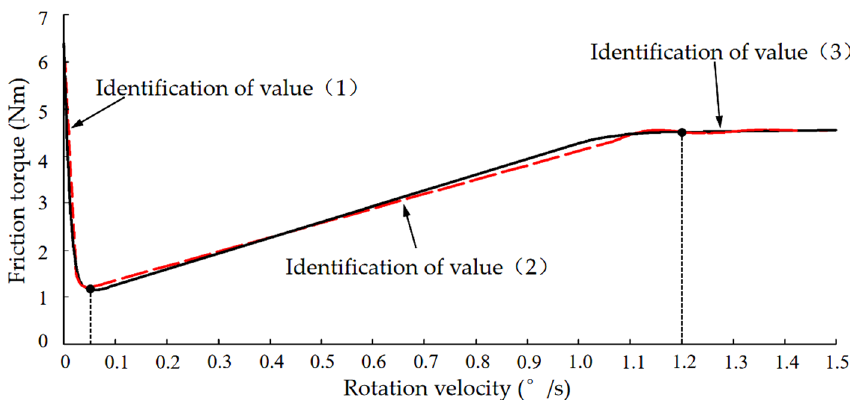
Figure 6. Results of Stribeck curve parameter identification.